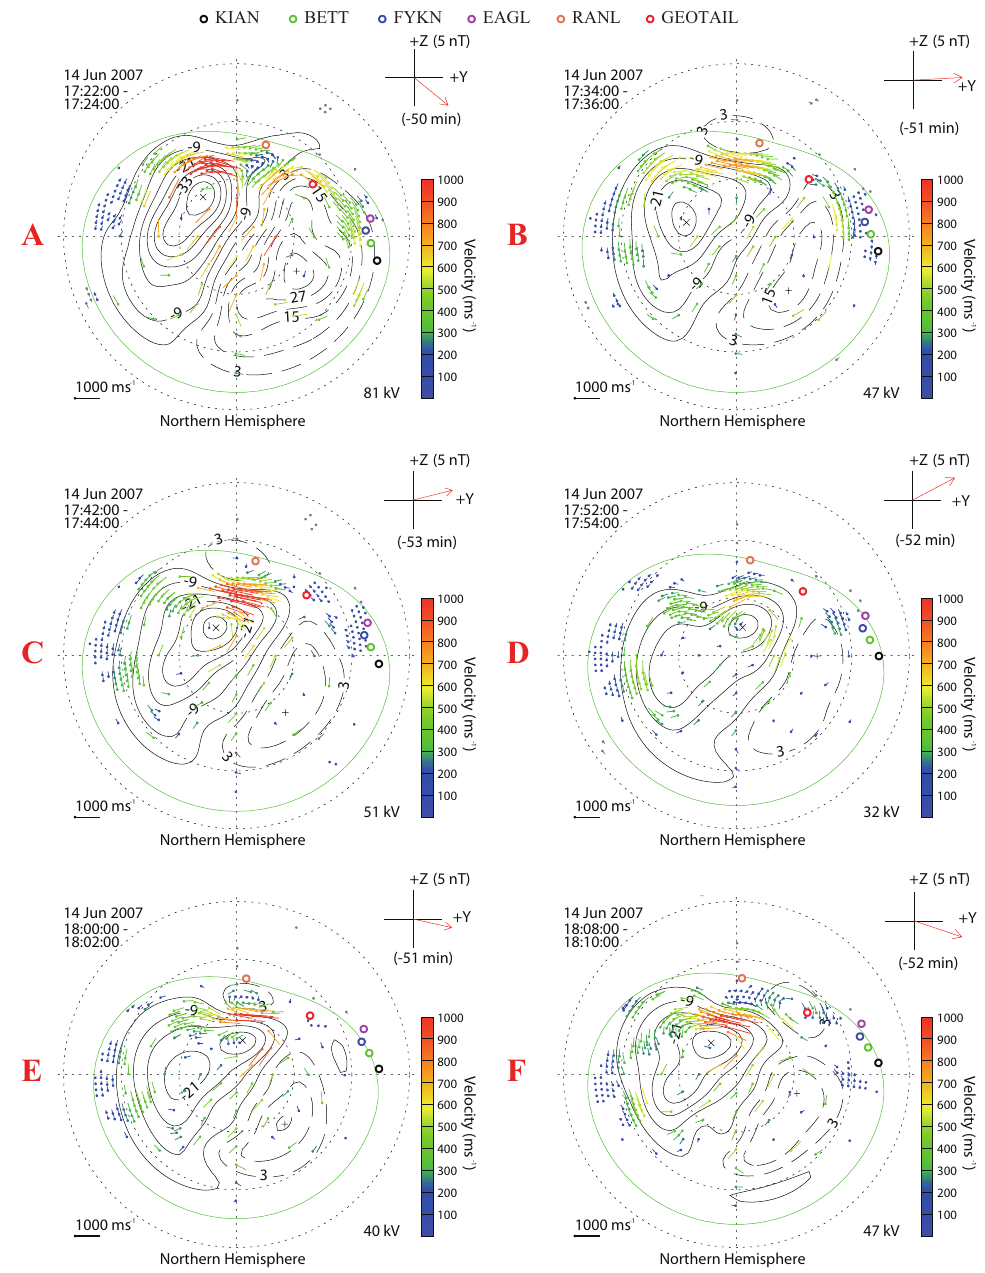
Fig. 10. SuperDARN backscatter and (mainly dayside) convection plots. (A) 17:22–17:24UT; (B) 17:34–17:36UT; (C)